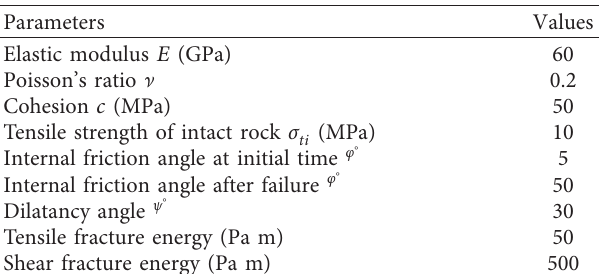
Figure 6: The failure state of several schemes under different dilatancy angles: (a) tensile strength is 3.7 MPa; (b) tensile strength is 10MPa (0-no failure; 1-tensile failure now; 2-shear failure now; 4-tensile failure past; 8-shear failure past). Table 4: Finalized input parameters of Lac du Bonnet granite in GDEM.